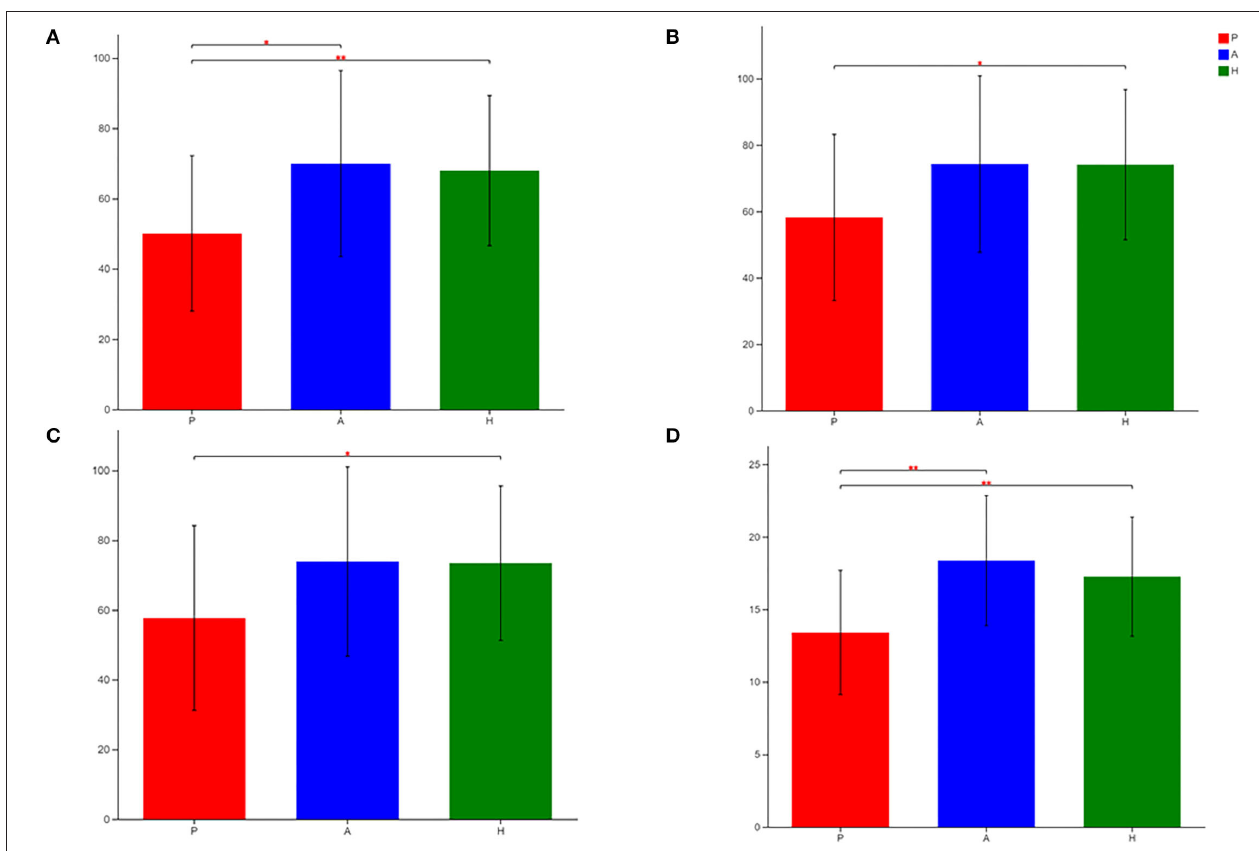
FIGURE 8 | Differences in sobs (A) , ace (B) , Chao (C) , and pd (D) of fungal flora among patients with Peutz–Jeghers syndrome (PJS) (group P), asymptomatic relatives (group A), and healthy controls (group H) at the OTU level (Student’s t -test, * p < 0.05; ** p < 0.01).